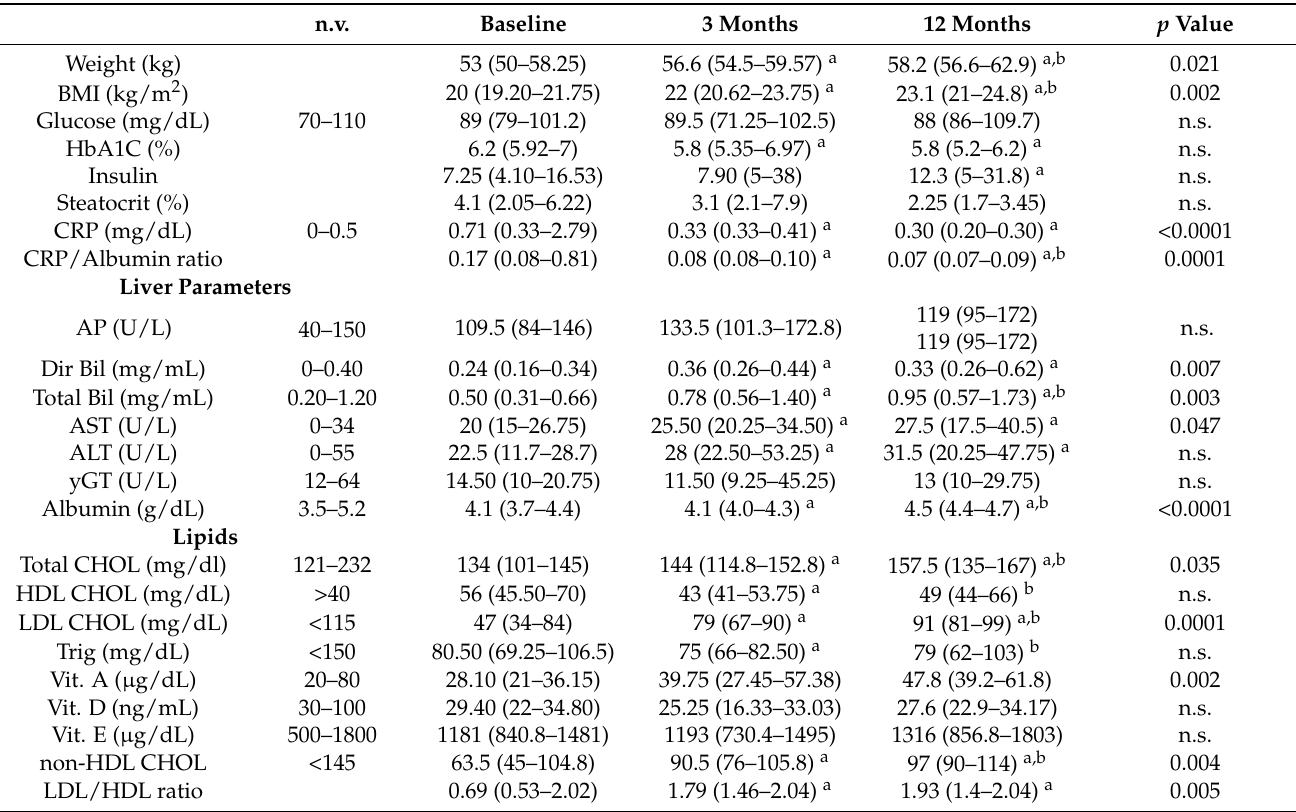
Table 2. Comparison of anthropometric and biochemical parameters at baseline, and after 3 and 12 months of ETI therapy. Data are reported as median (IQR). a : p < 0.05 vs. baseline, b : p < 0.05 vs. 3 months. n.v.: normal values.